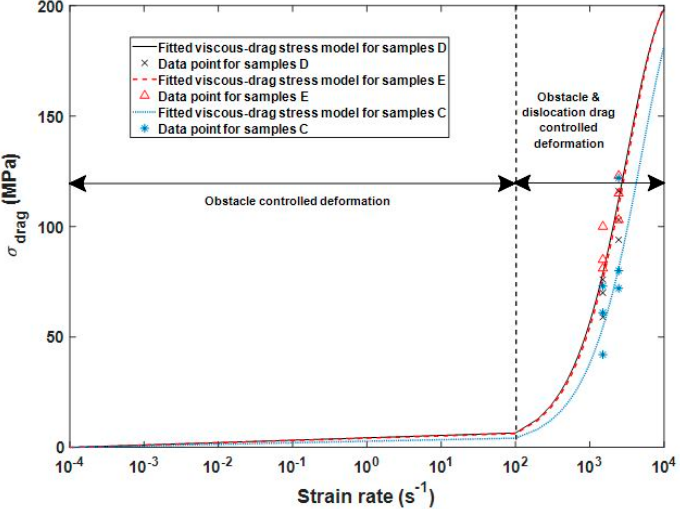
Figure 10. Evolution of the viscous drag stress as a function of strain rate for samples C, D, and E. Table 4. Calibrated curve-fitting parameters for the viscous drag component of yield and flow stress for DMLS Ti6Al4V(ELI) samples.